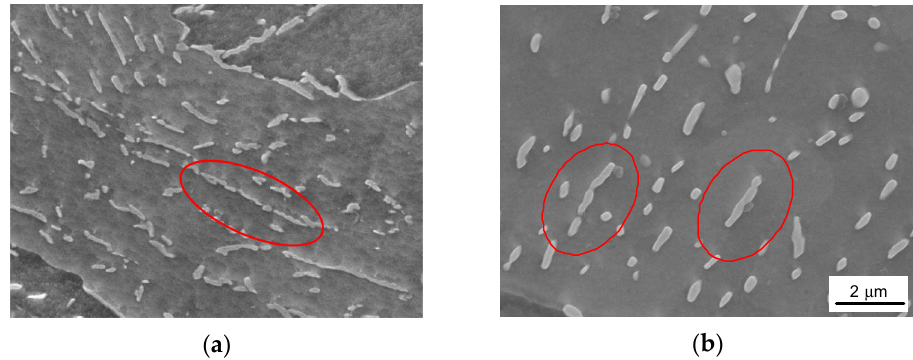
Figure 10. Cementite spheroidization process in the initial bainite microstructure. Detail of the initial bainite laths in the as-transformed bainite microstructure, where rows of cementites are observed along boundaries between laths as indicated by the red circle ( a ). Formation of necks during annealing that cause cementite break-up into globular shapes of the cementite rows in the interface between laths ( b ).